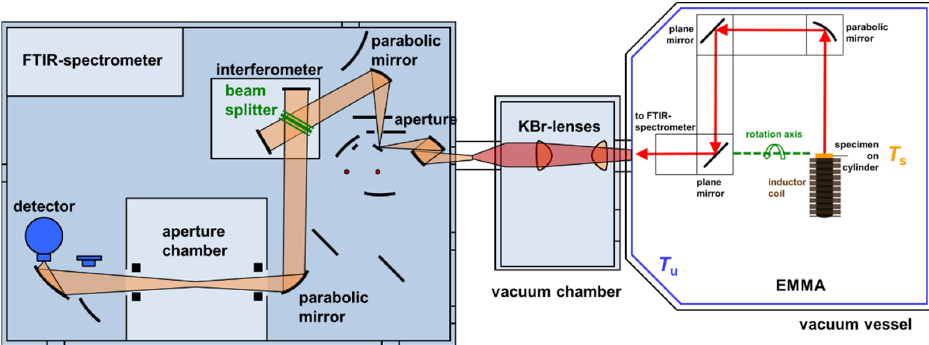
Figure 4. Sketch of the improved EMMA. The inductor is placed in the vacuum vessel on the right, which is coupled to the FTIR-spectrometer Vertex 70v on the left by an additional vacuum chamber in the middle. The intensity emitted by the specimen is detected by the spectrometer. The whole beam path can be evacuated.